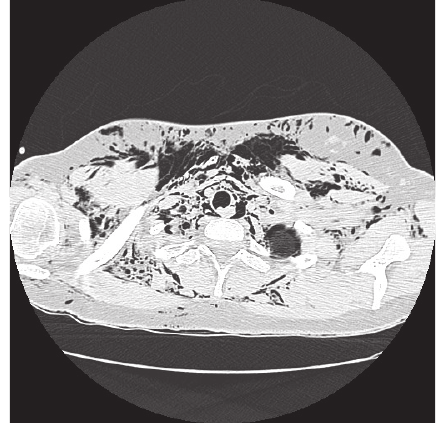
Figure 2: Cervical computed tomography showing extension of subcutaneous emphysema to the cervical